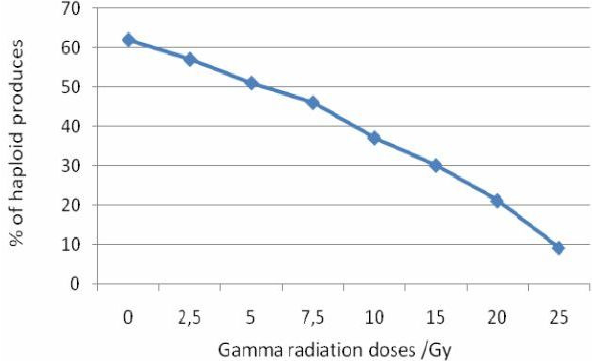
Fig. 2. The effect of MS medium with different BAP and NAA Fig. 5a. Effect of gamma radiation doses on anthers (to produce haploid plants)